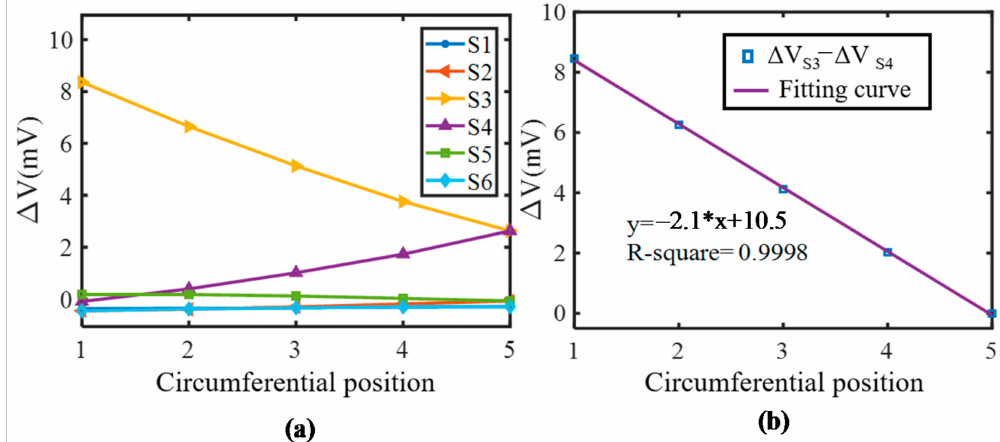
Figure 12. Simulation results for the second layer. ( a ) Voltage variation of each coil; ( b ) Difference value between adjacent